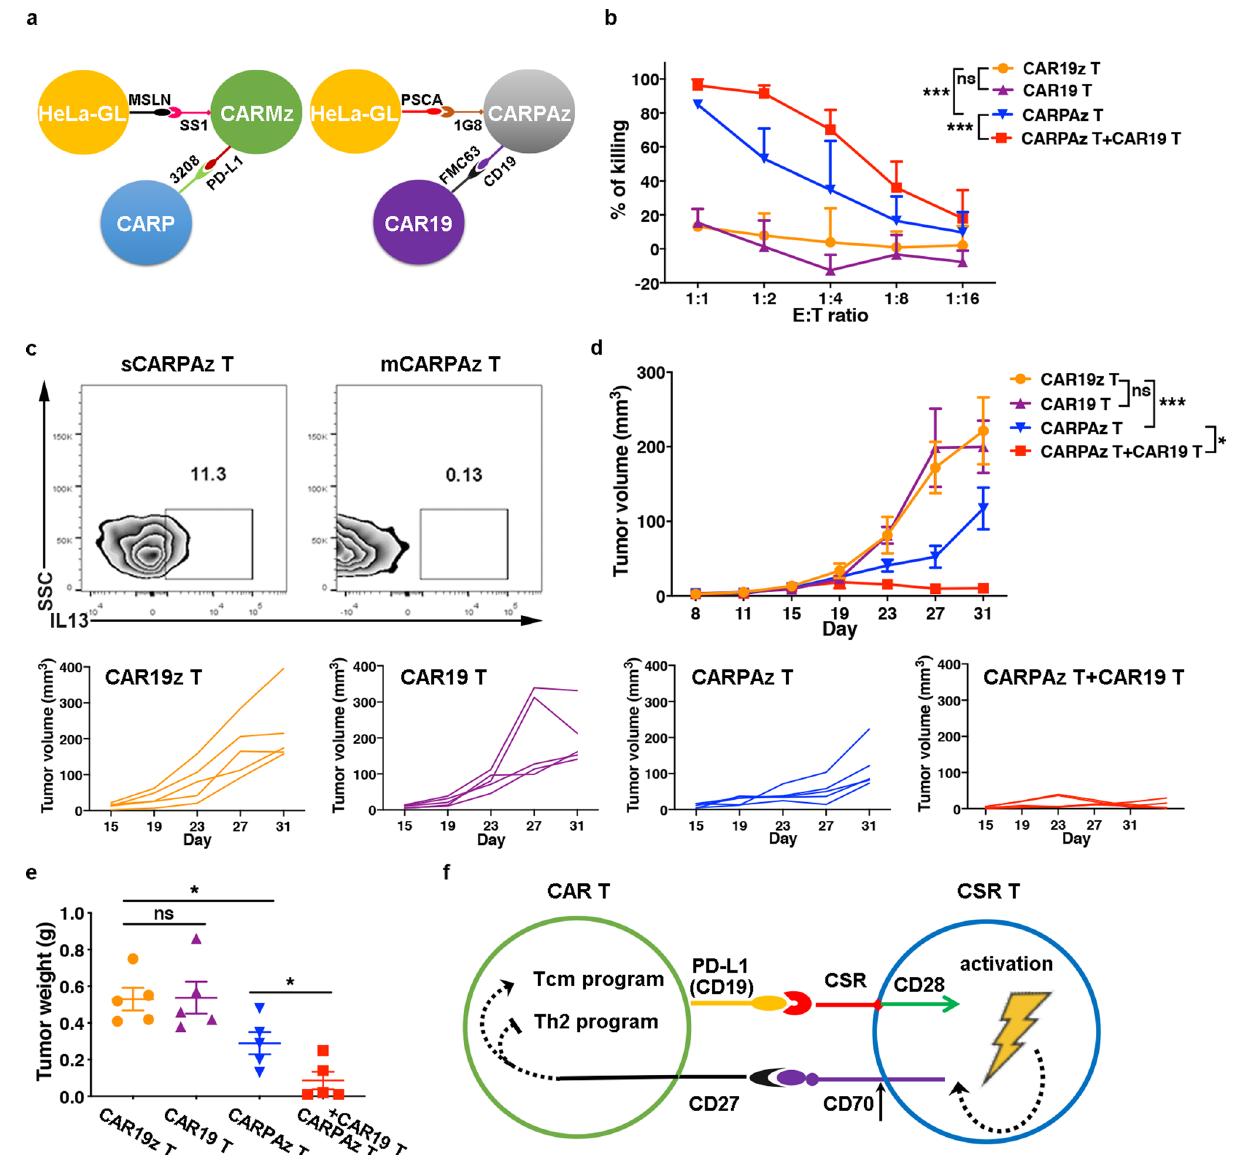
Fig. 7 | CAR19 T cells enhance the antitumor effect of CARPAz T cells. a Schematic diagram of the heterotypic binding of CARMz T cells to CARP T cells (left)and CARPAzTcells toCAR19 Tcells(right).Antigensand scFvsareindicated. b CAR19 T, CARPAz T, a mixture of CAR19 T and CARPAz T and control CAR19z T cells cytotoxicity against targeting HeLa-GL cells were measured at various E:T ratios. Data are presented asmean±SD ( N =3 independent experiments). p Values (CAR19 T vs. CAR19z T=0.504, CARPAz T vs. CAR19z T=1.591E-09, CARPAz T+ CAR19 T vs. CARPAz T=2.471E-04). c Percentage of IL3 + cells in individual CARPAz T (sCARPAz T) and CARPAz T from a mixture of CARPAz T and CAR19 T cells (mCARPAz T)post-coculture with HeLa-GL cells at a 1:1 E:T ratio for 24h (gated on CD3 + CD19 + cells). d , e NSI mice bearing HeLa-GL tumors (5×10 5 , established